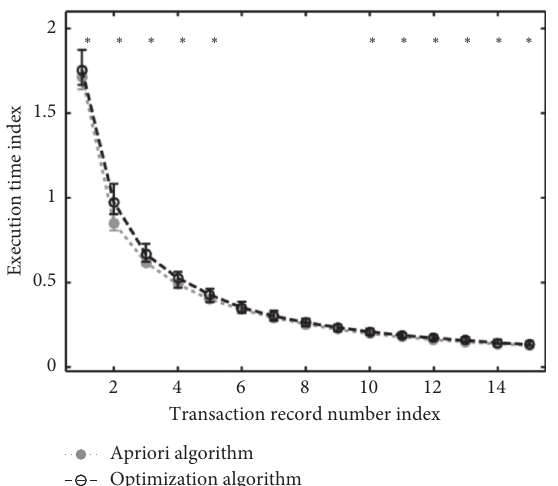
Figure 2: Comparisons of execution time between two algorithms under different transaction